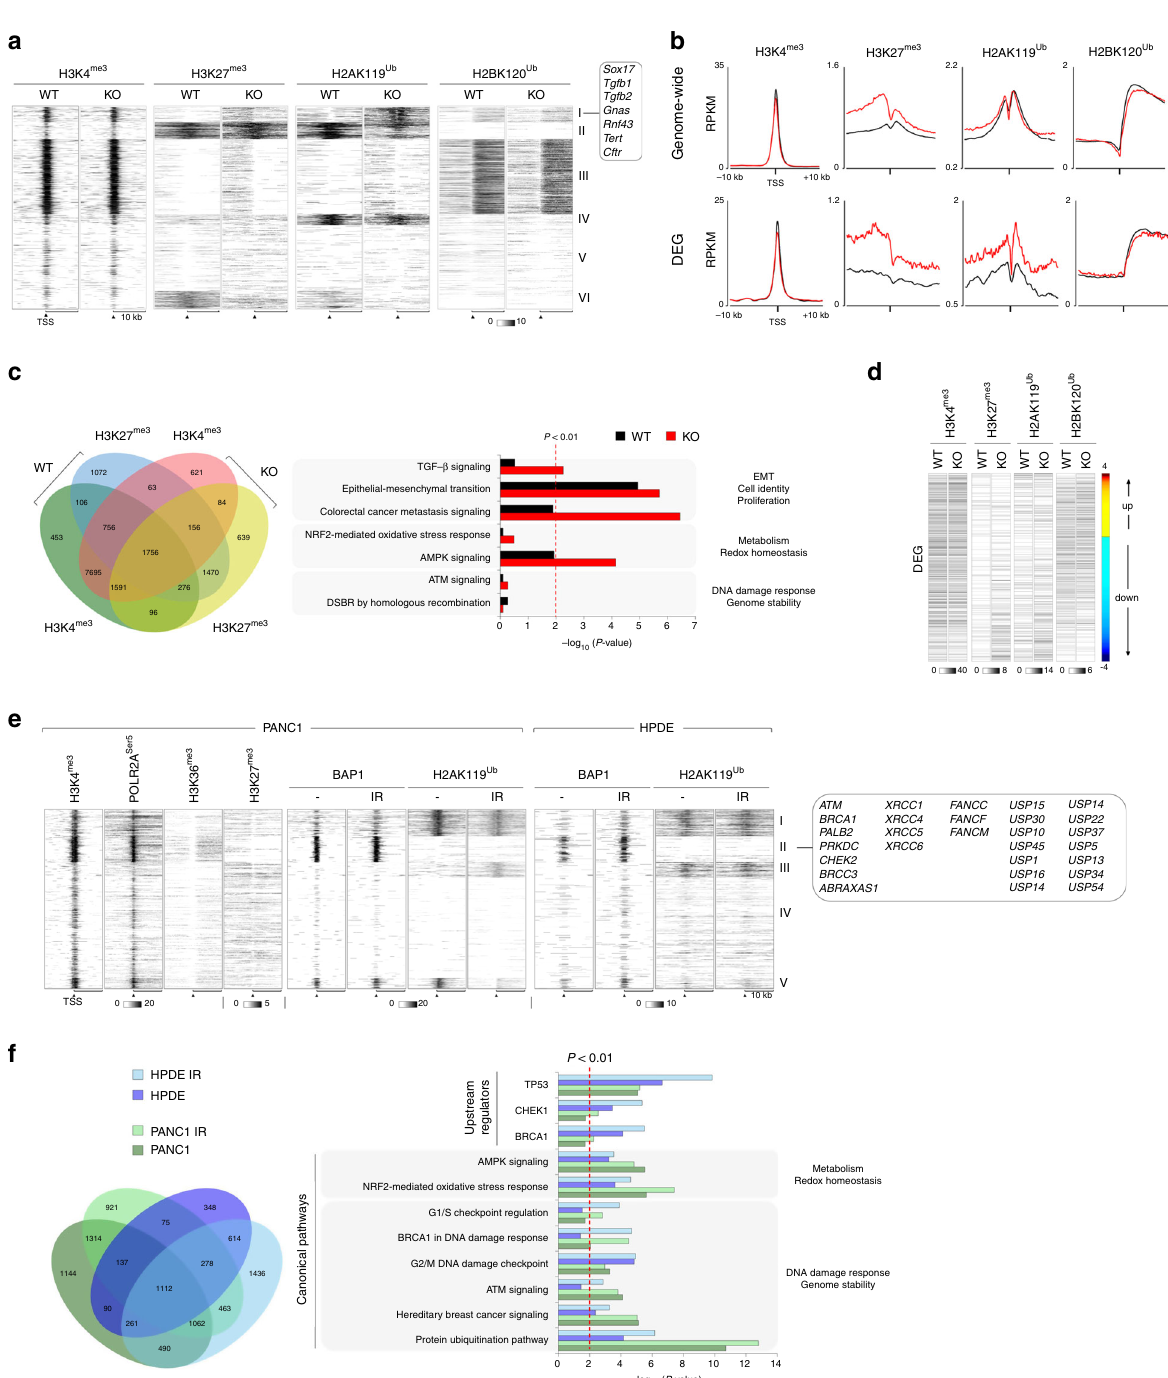
Fig. 6 BAP1 binds active chromatin and regulates the response to DNA damage. a Composite heatmap showing the K -means clustering ( K = 6) of the genome-wide distribution and signal intensity of the indicated histone modi fi cations in Pdx1 Cre ;Kras G12D wild-type and Bap1 -knockout cells. Each horizontal line represents the normalized signal intensity for a gene over its transcription start site (TSS). A ±10 kb window is shown for each TSS. The grayscale bar shows the normalized signal intensity (RPKM, reads per kilobase per million mapped reads). b Read density pro fi les of the indicated histone modi fi cations over the TSS ± 10 kb genome-wide (top) and DEG (bottom) in Pdx1 Cre ;Kras G12D wild-type and Bap1 -knockout cells. The y axis shows the mean RPKM. c Left: Venn diagram showing the overlap of the indicated histone modi fi cations in Pdx1 Cre ;Kras G12D wild-type and Bap1 -knockout cells. Right: IPA of canonical pathways linked to de novo bivalent genes in Bap1 -knockout cells. The x axis corresponds to the raw binomial p -values. d Heatmap showing the signal intensity of the indicated histone modi fi cations over the DEG (fold change> 1.4 and p < 0.05) in Pdx1 Cre ;Kras G12D wild-type and Bap1 -knockout cells. The color bar represents DEG sorted based on the fold-change difference in gene expression between knockout and wild-type cells. e Composite heatmap showing the K -means clustering ( K = 5) of the genome-wide distribution and signal intensity of the indicated histone modi fi cations, POLR2A Ser5 , and BAP1 in PANC1 and HPDE before and 1 h after exposure to 10 Gy of IR. The grayscale bars show the normalized RPKM. f Left: Venn diagram showing the overlap of genes bound by BAP1 in HPDE and PANC1 before and after IR (10 Gy). Right: canonical and upstream regulator IPA of BAP1-bound genes in HPDE and PANC1 in response to IR. The x axis corresponds to the raw binomial p